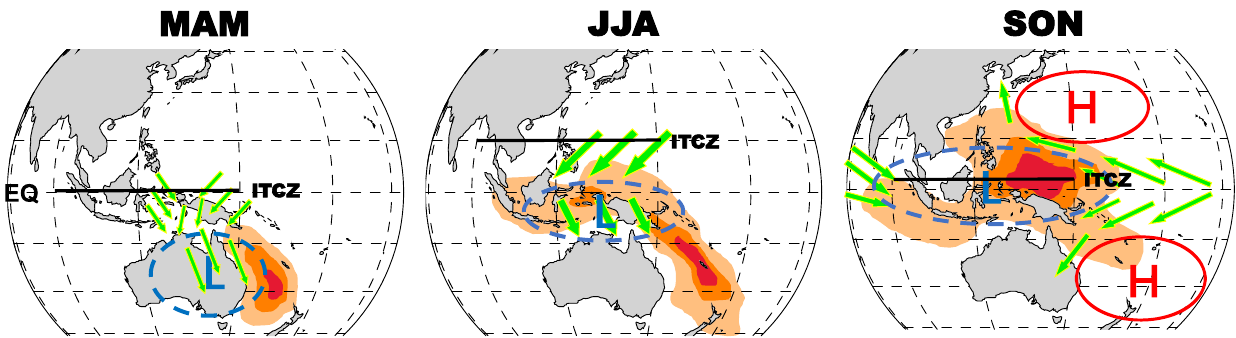
Fig. 4 Schematic of mechanisms. Schematic summarizing the interhemispheric propagation of western Paci fi c SST anomalies starting from boreal spring as described in this study. Green arrows are surface wind anomalies. Solid black line is the approximate position of the western Paci fi c ITCZ in different seasons. Dashed and solid circles represent anomalous low and high pressure, respectively. Colored shading denotes SST anomalies. During boreal spring, the SWP warming-induced anomalous low pressure and northerly winds weaken the trade winds south of the equator, initiating the WES feedback. During boreal summer, the SST warming progresses toward the north of Australia, and the atmospheric responses lead to modulation of cross-equatorial monsoon fl ow and suppression of turbulent fl ux release in tropical western Paci fi c. The WES feedback maintains the northward propagation of SST anomalies. During boreal autumn, the warming signal crosses the equator into the northern western Paci fi c, in fl uencing the Northern Hemisphere